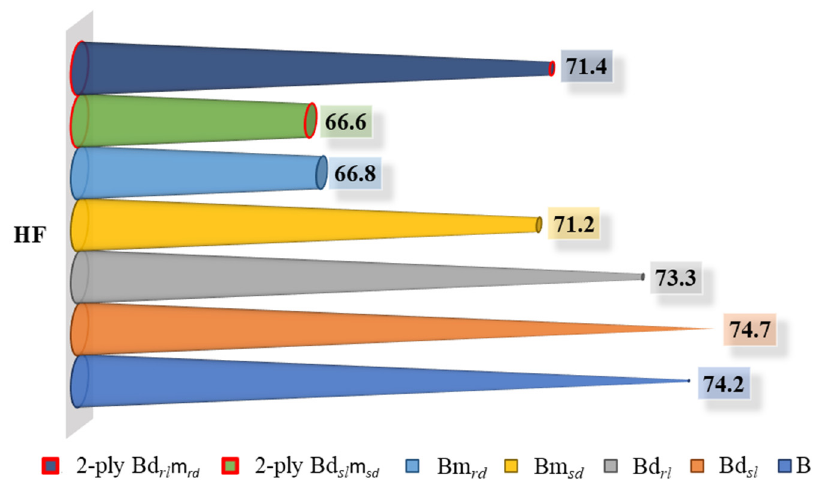
Figure 16. Results obtained for handfeel (HF) for all the embossed samples and the reference paper, B, for the different finishing geometries of the 3D steel plates.